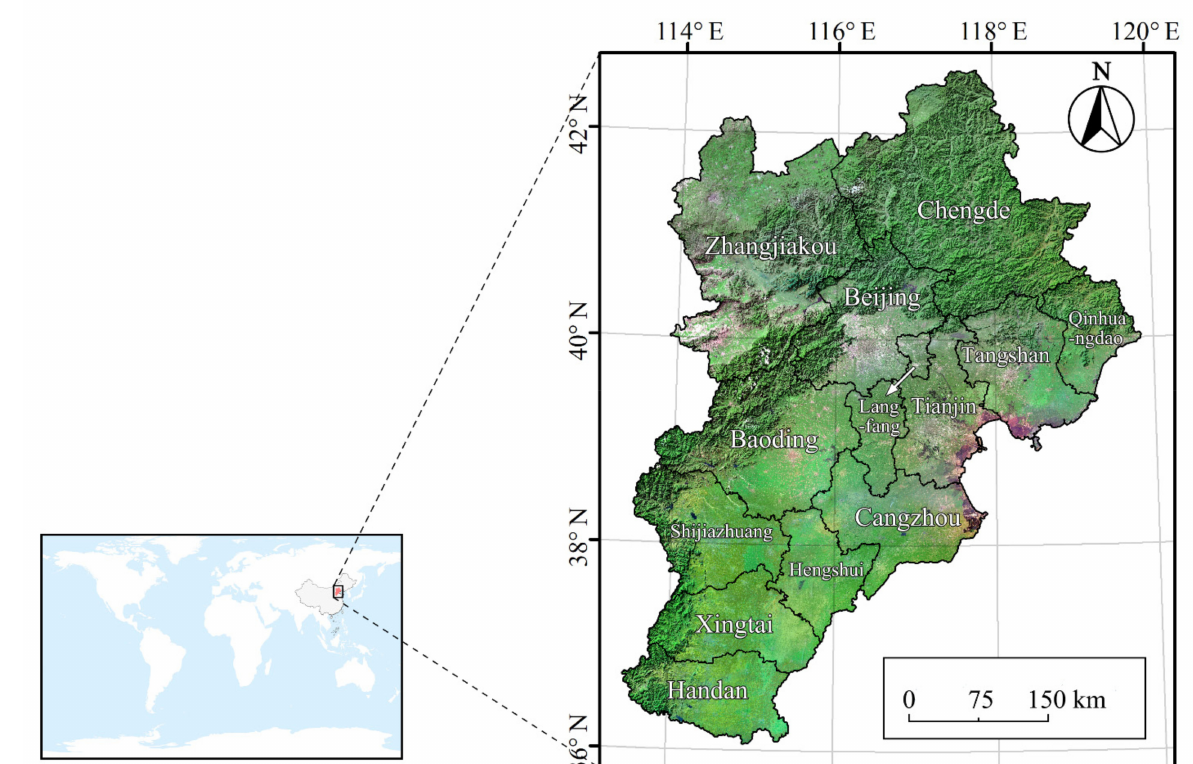
Figure 2. Geographical location of the study